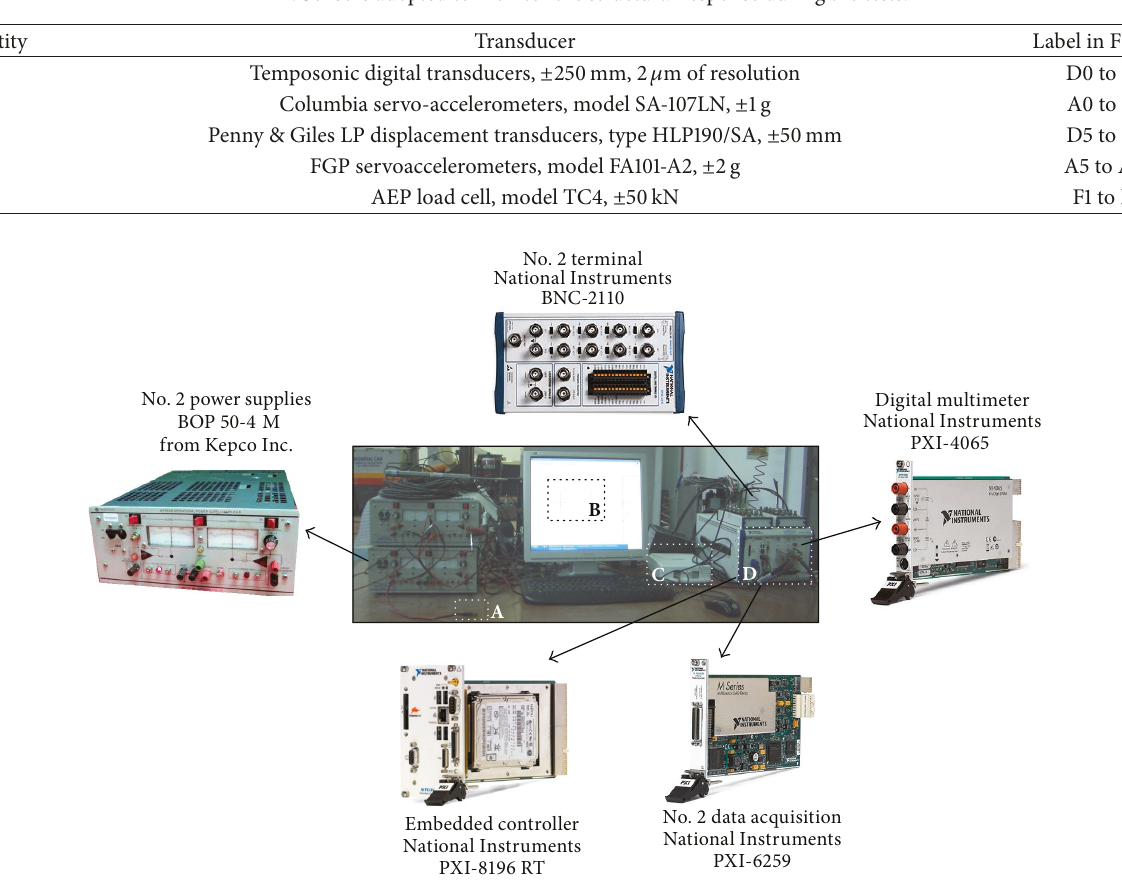
Table 1: Sensors adopted to monitor the structural response during the tests.